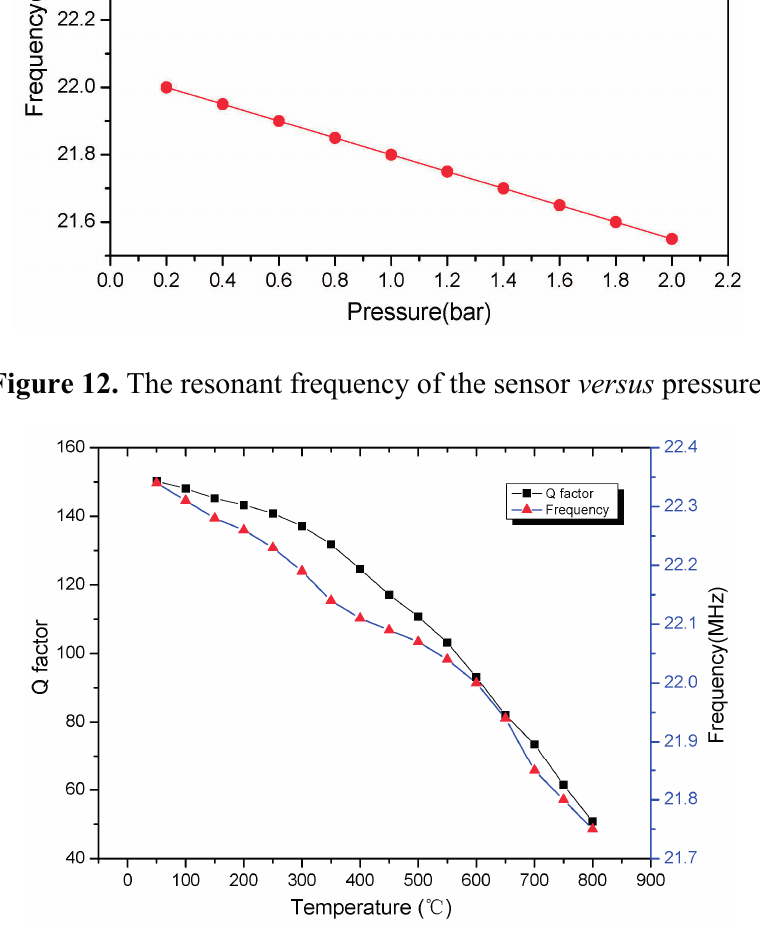
Figure 13. The resonant frequency of the sensor versus